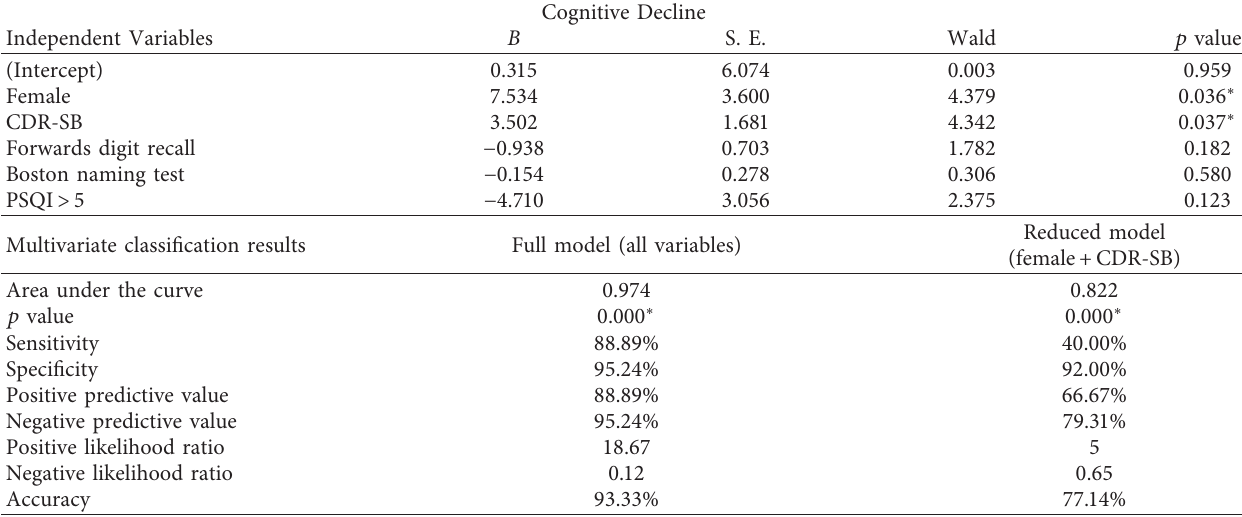
Table 3: Binary logistic regression of predictors for cognitive decline in participants with